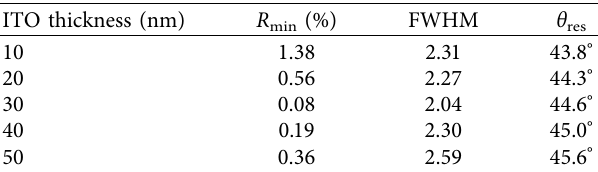
Figure 3: Changes in chip reflectivity when thicknesses of Ag and ITO change from 10 to 50; the red line represents the best structure; the green line in (b) represents the reflectivity of the chip when ITO thickness is 120; (f) the electromagnetic field distribution corresponding to the structure represented by the red line in (b) (unit: nm). Table 1: Reflectivity changes caused by ITO with different thicknesses.